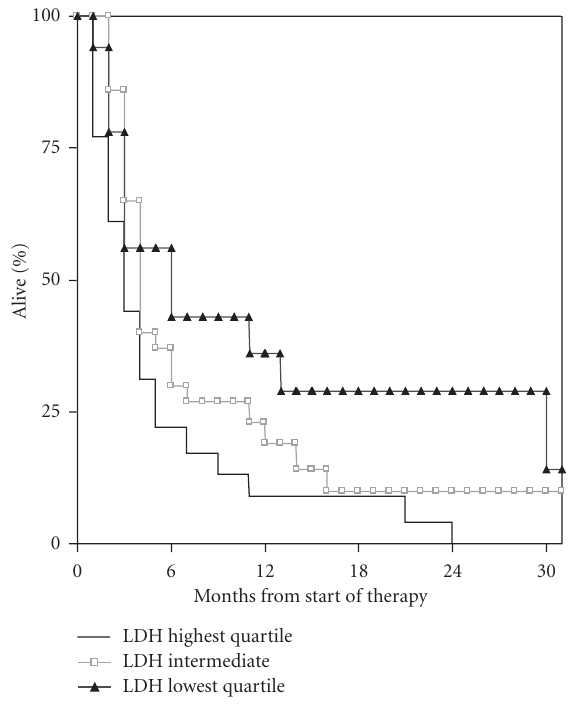
Figure 3: Kaplan-Meier curves for overall survival: LDH highest quartile ( n = 25) versus LDH lowest quartile ( n = 25) versus intermediate ( n = 50); P = 0 .